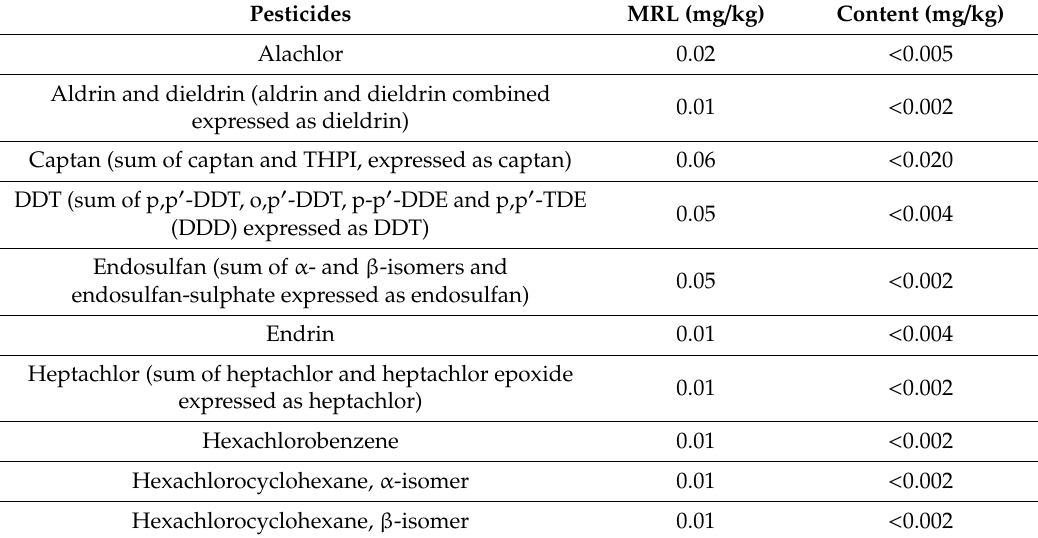
Table 7. Residue levels and maximum residue levels (MRLs) of pesticides (mg / kg) in wild thyme sample.